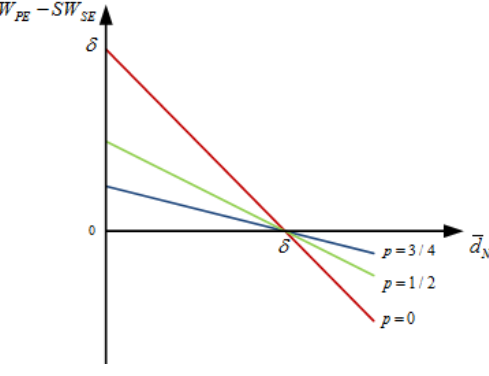
Figure 2. Social welfare difference.